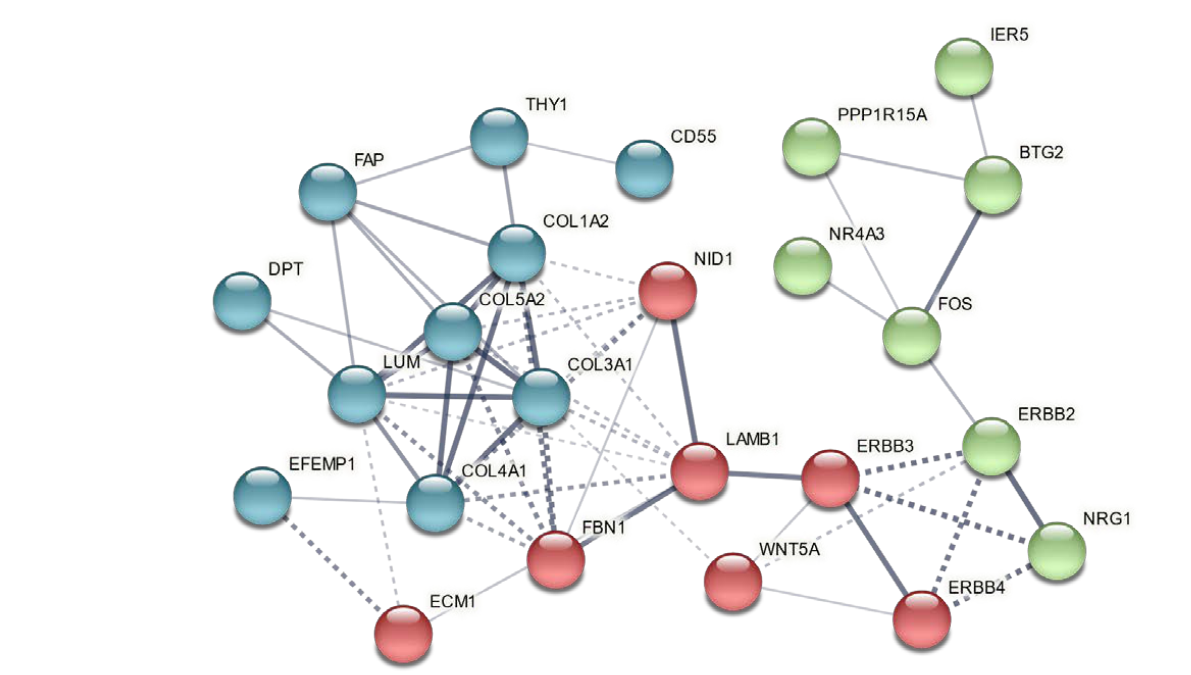
Figure 4. Genes commonly altered in cardiac and intercostal skeletal muscle encode functionally associated proteins. A vector graphic network created using STRING network version 11.5 with K means clustering of proteins encoded by differentially expressed genes commonly altered in both skeletal muscle and cardiac tissues of GGF2-treated post-MI pigs is shown. Full gene names with functions are provided in Table 1, except for NRG1 (neuregulin 1) and its receptors (ERBB2-4). Bubbles represent individual proteins, and lines represent associations between proteins. Line thickness indicates edge confidence, low (0.150), medium (0.400), high (0.700) and highest (0.900). Line shape indicates the predicted mode of action. Each color represents an individual cluster.